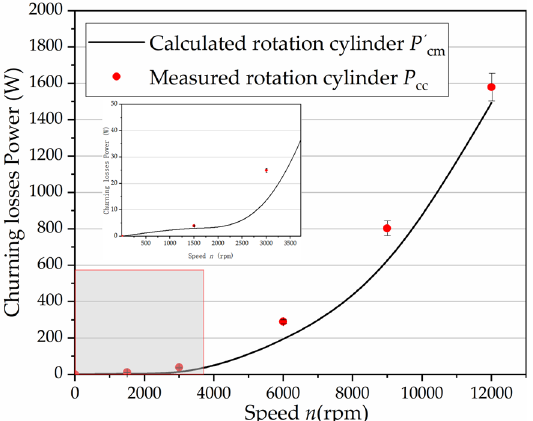
Figure 7. Comparisons between the experimental results and the results from the method of least-squares curve fitting for the cylinder block.